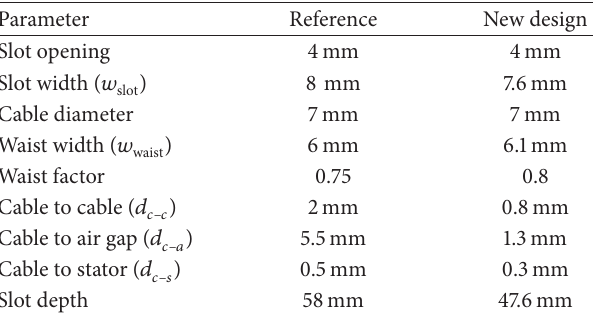
Figure 2: A stator slot opening and the two cables closest to the air gap showing the geometry parameters used in this